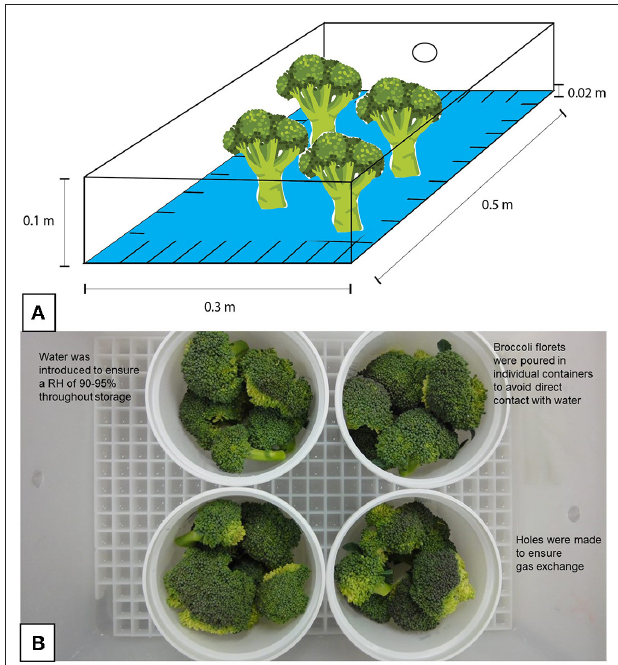
FIGURE 1 | Arrangement and storage conditions of broccoli florets exposed to H 2 O 2 . (A) Broccoli florets were placed vertically inside a box with a grid inside, both made of plastic, and then different H 2 O 2 solutions [0mM (control) to 5mM for 180min] were poured to a depth of 2.0cm. (B) Once the ∼ exposure was concluded, the florets were stored in plastic containers with 300g of plant tissue (experimental unit), which were placed in boxes for ∼ storage. Water was introduced into these boxes to ensure high relative humidity during storage, and they were subsequently covered. To avoid CO 2 accumulation, two holes were drilled in the sides of each